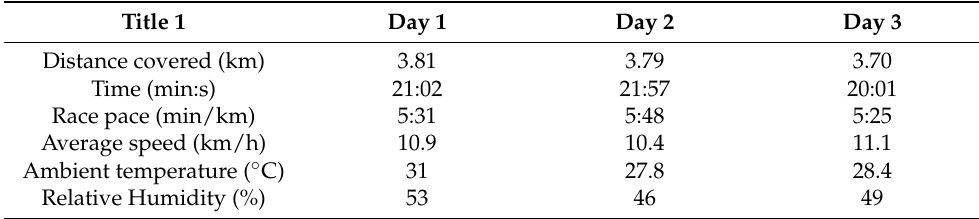
Table 2. Data on environmental conditions and intensity of effort.